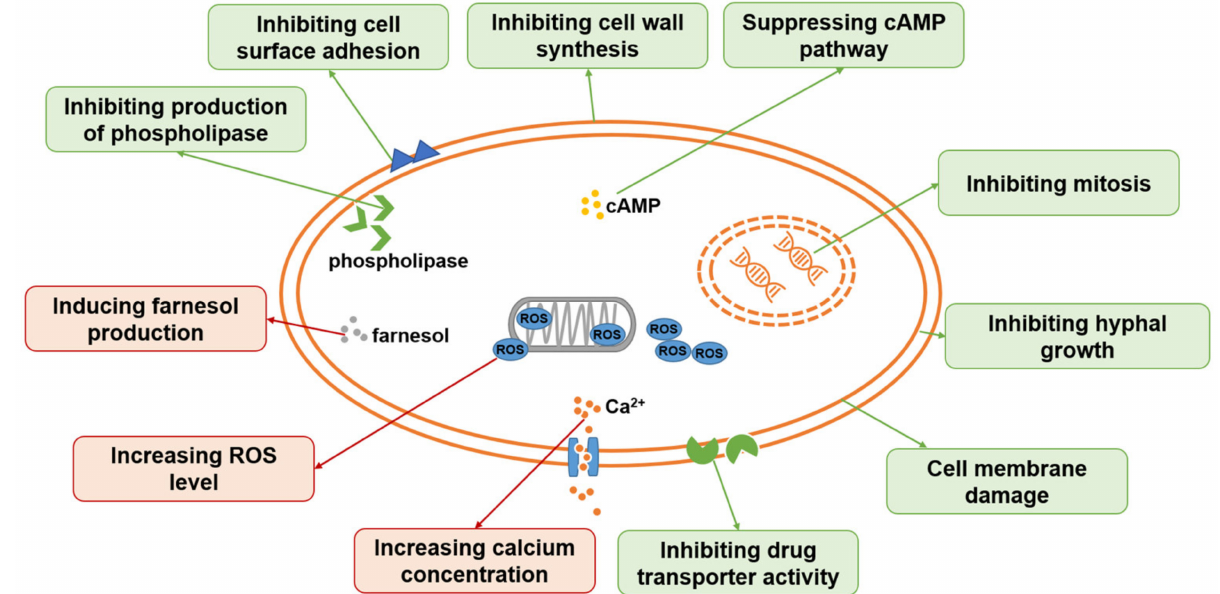
Figure 2. Antifungal mechanisms of some TCM